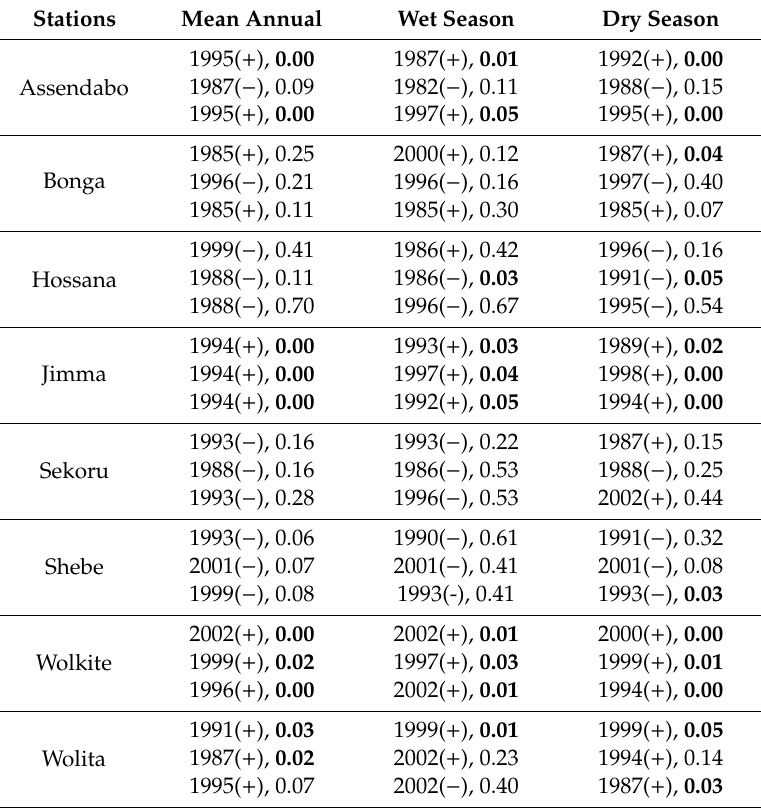
Table 1. Summarized results of Pettit test for the mean annual and seasonal time scales. The first, second and third rows indicate for the minimum, maximum, and mean temperature, a positive sign in the parentheses indicate an increasing shift, and a negative sign indicates a decreasing shift. Bold numbers indicate p -values for statistically significant change